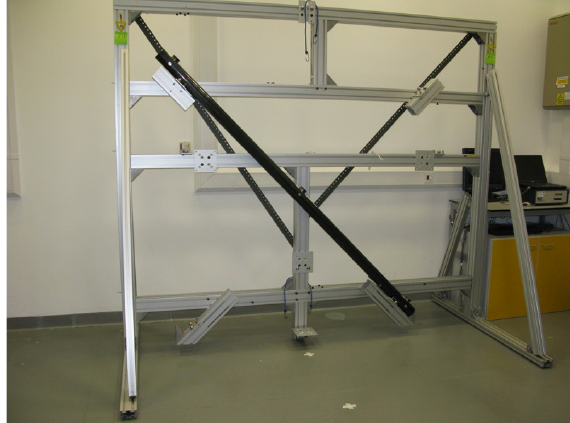
Fig. 3. B89.4.19 artefact and support